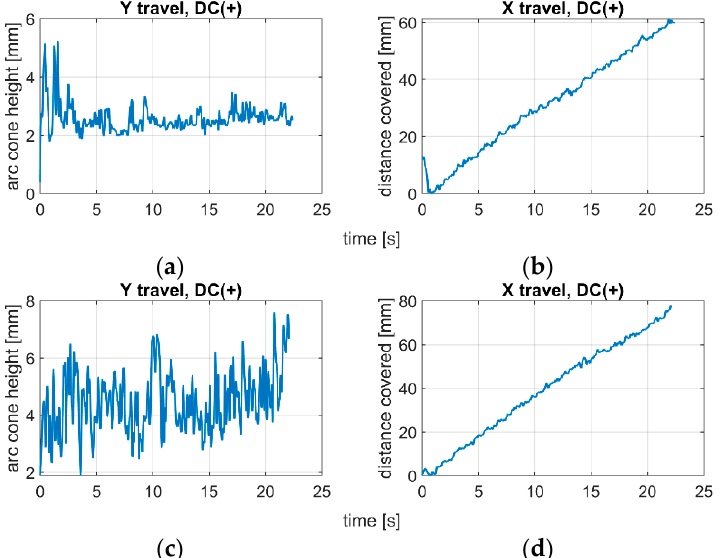
Figure 13. Centroid changes of welding arc ROI in IR image during positive polarity cladding with a constant arc length: ( a ) welding arc length estimate for short arc (s5); ( b ) welding speed estimate for short arc; ( c ) welding arc length estimate for long arc (s3); ( d ) welding speed estimate for long arc.